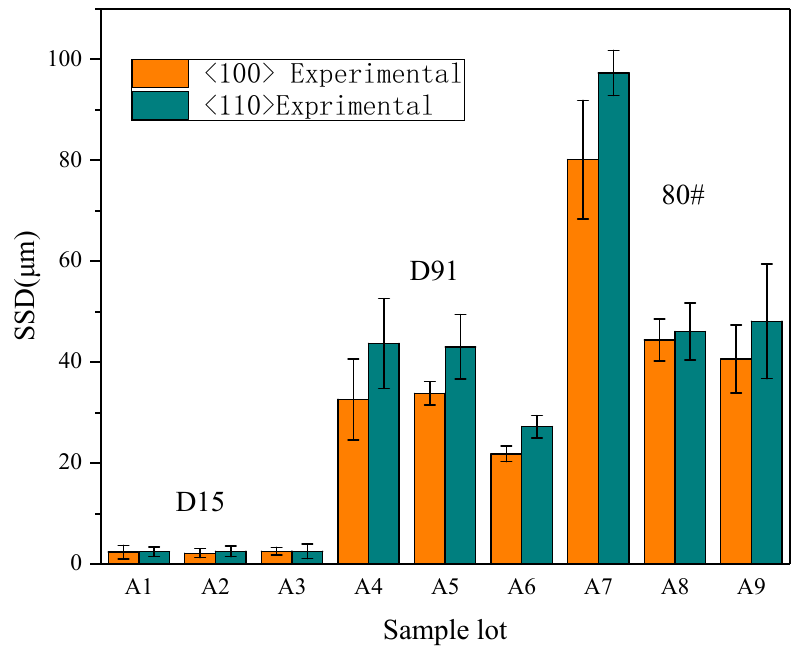
Figure 10. Comparison of the subsurface damage (SSD) along the <100> and <110> direction grinding.